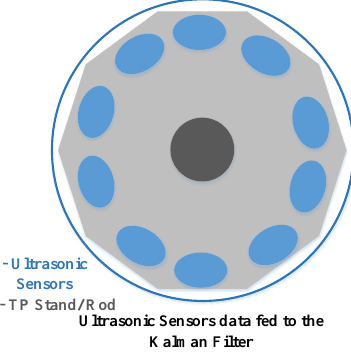
Figure 4. Ten ultrasonic sensors mounted in a circular order.